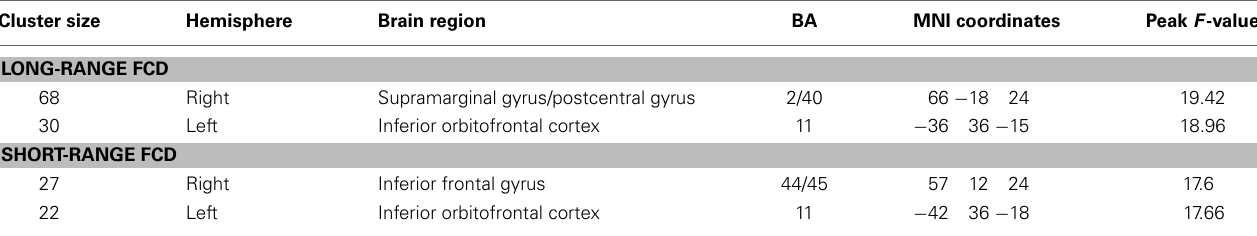
Table 3 | Sex by the general risk propensity score interaction effects on long- and short-range FCD.